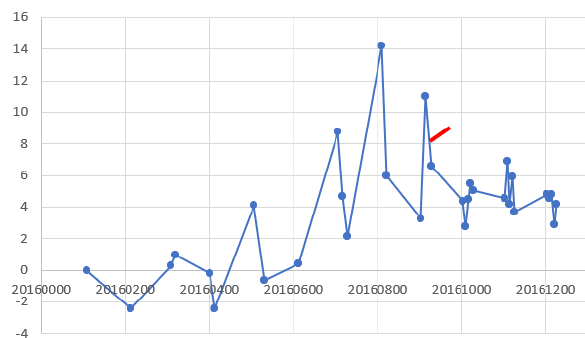
Figure 6. Surface displacement in mm, where there is the collapsed building, the redline indicates the date of